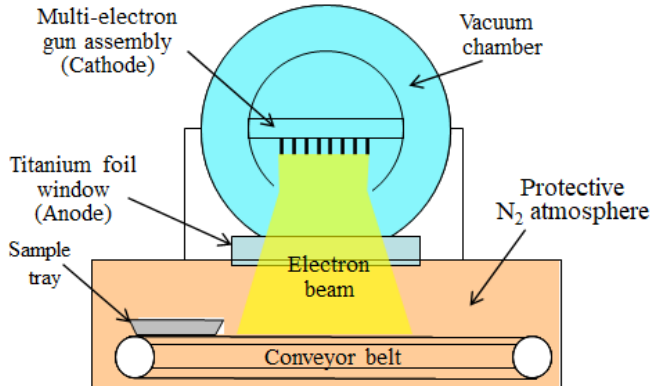
Figure 3. Schematic diagram of electron curtain processer. ( Iwasaki Electric Group Co., Ltd., Tokyo , Japan ).